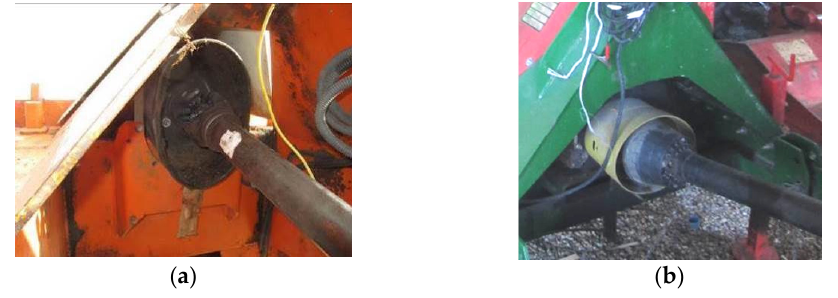
Figure 9. Example of observed unshielded power take ‐ off (PTO) shafts ( a ) and partially shielded PTO ( b ) Hydraulic components (§ 4.4.2 6th revision draft of EN 13525).